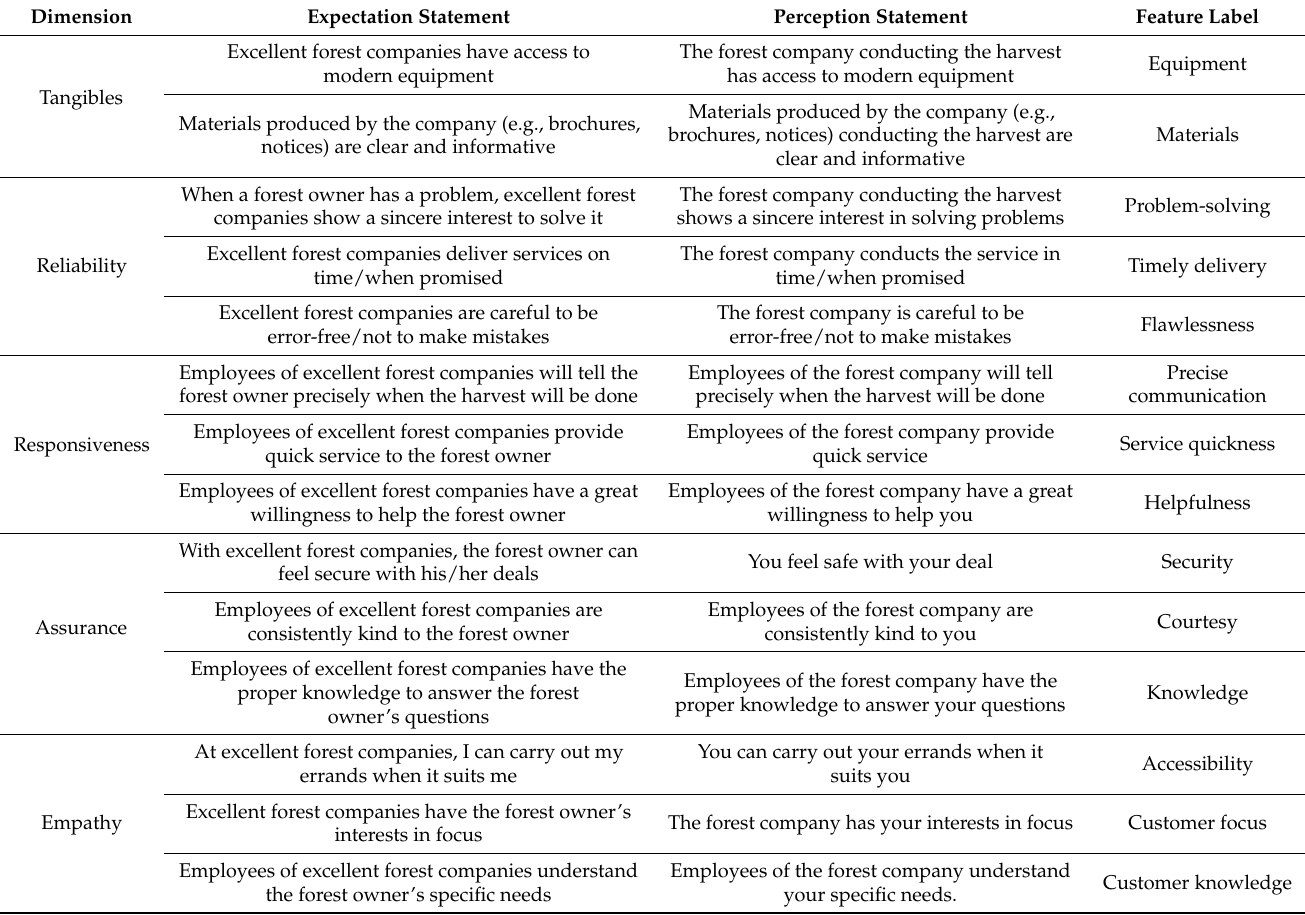
Table 1. Statements used to study forest owners’ expectations and perceptions of service quality. Respondents ranked the statements on a scale of 1 to